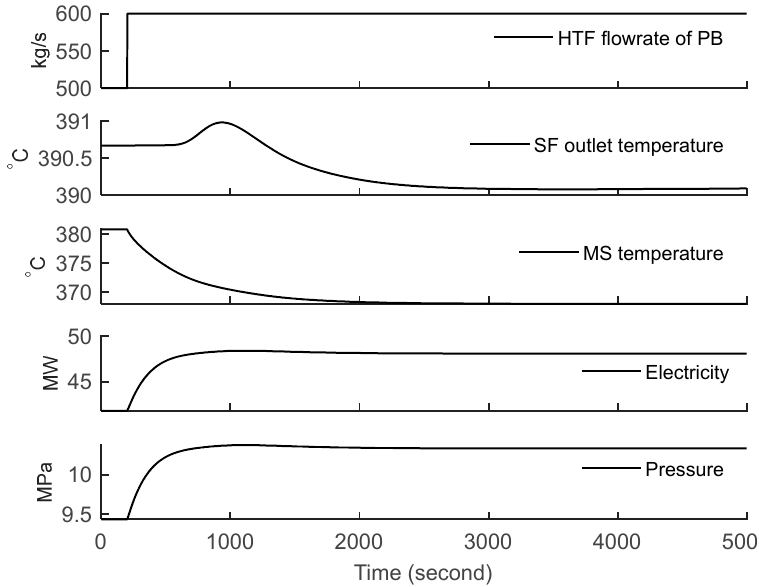
Figure 3. System response to step change of HTF flowrate of PB.